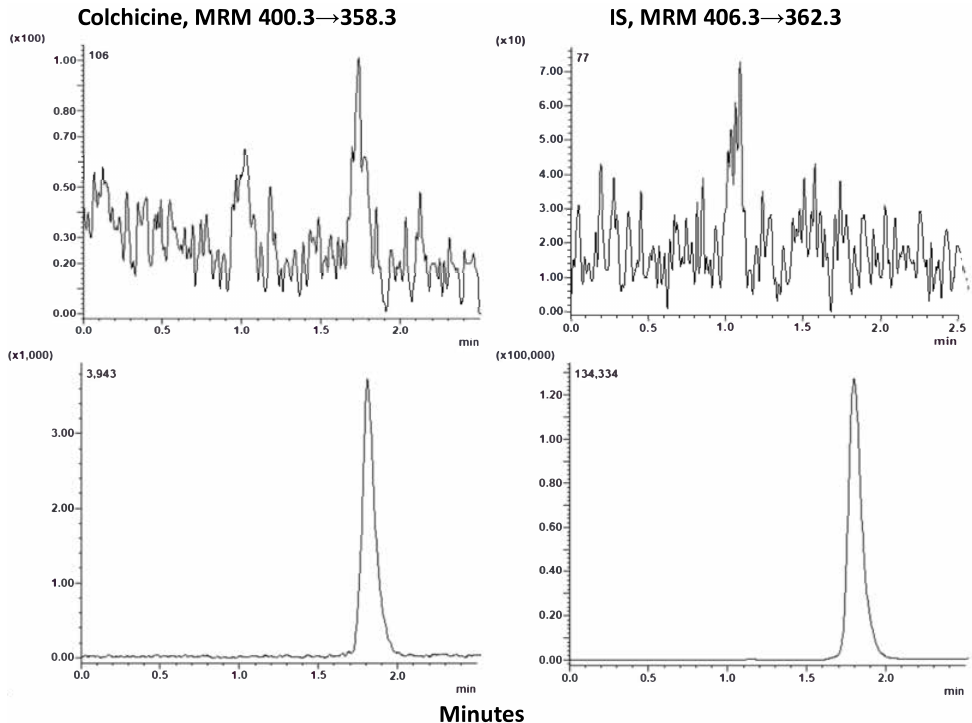
Figure 2. MRM ion-chromatograms of colchicine ( left panels ) and IS ( right panels ). Upper panels are blank plasma samples (COL and IS-free), lower panels are from a plasma sample spiked with IS and COL at the lower limit of quantitation. The plasma volume was 0.1 mL for each chromatogram.